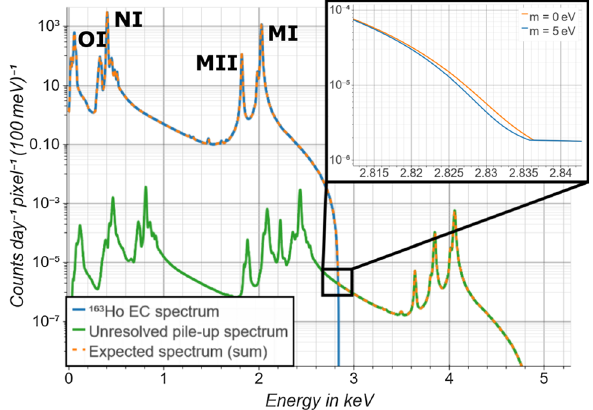
Fig. 1 TheoreticalECspectrumof 163 Hoaccordingtothemodeldevel- oped in [11] (blue solid line) with 10 Bq of 163 Ho per pixel. The green solid line represents the unresolved pile-up spectrum calculated as the autoconvolution of the 163 Ho spectrum for an unresolved pile-up frac- tion of 3 × 10 − 6 . Insert: Magnification of the end point region of the 163 Ho EC spectrum for a vanishing neutrino mass (orange) and a neu- trino mass of 5 eV (blue)